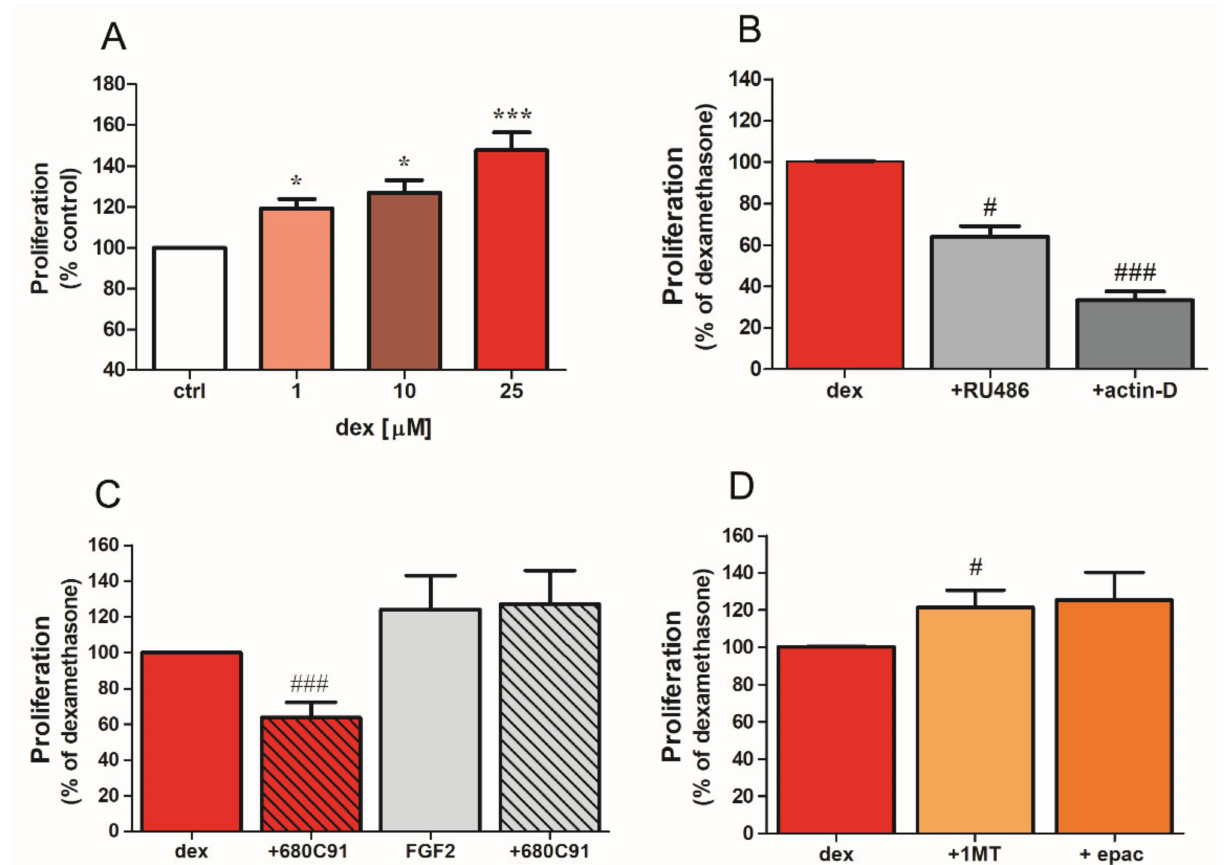
Figure 5. TDO mediates dex-induced SK-Mel-28 proliferation. ( A ) Cells were treated without (ctrl) or with increasing concentrations of dex for 48 h. Data are plotted as percent of control. Mean ± SE ( n = 7; * p < 0.05, *** p < 0.001 versus ctrl). ( B – D ) Cells were treated with dex (25 µ M) alone (dex) or in presence of ( B ) RU486 (1 µ M) or actinomycin D (10 nM) or ( C ) 680C91 (40 µ M) and FGF2 (10 ng/mL) or ( D ) 1-MT (40 µ M) or epacadostat (1 µ M), and proliferation was assessed. Data are plotted as mean ± SE ( n = 7; # p < 0.05, ### p < 0.001 vs. dex